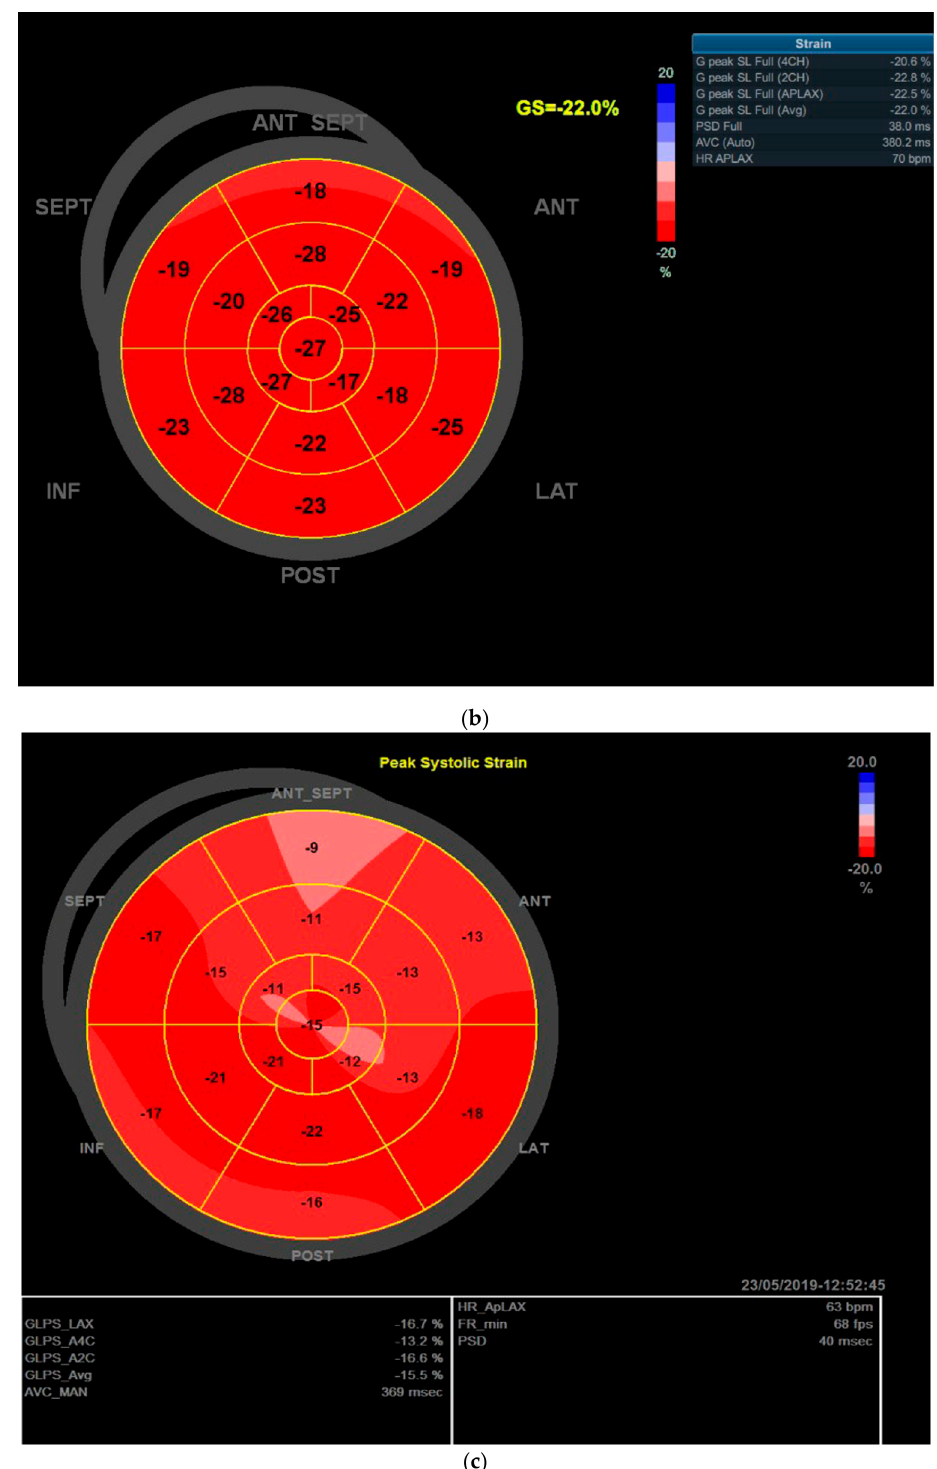
Figure 1. Graphical representation of left ventricular (LV) segments and longitudinal strain (LS) in individual LV segments assessed via speckle-tracking echocardiography (STE), based on the Recommendations for Cardiac Chamber Quantification published by the American Society of Echocardiography. ( a ) Graphical representation of the division of the LV into basal, medial, and apical segments. ( b ) So-called “bull’s eye” obtained in STE, showing LS values for all 17 LV segments in a healthy person. The LV walls are marked as follows: ANT—anterior, ANT-SEPT—anteroseptal, LAT—lateral, POST—posterior, INF—inferior, SEPT—inferoseptal. Negative numbers indicate the longitudinal strain (LS) value in the given LV segment. A global left